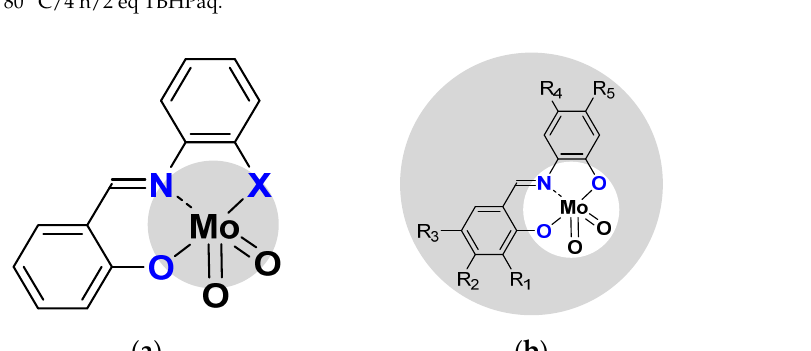
Figure 4. ( a ) Modification of coordination sphere X = O vs. X = S ( b ) Modification of the second sphere on R 1 to R 5 positions (specified in the text and in Table 1). Table 1. Results of cyclo-octene (CO) epoxidation under organic solvent-free conditions and selec- tivity towards cyclo-octene epoxide (COE) after 4 h. Comparison of first and second sphere influ- ence (Structures are those from Figure 4) and corresponding transition state.